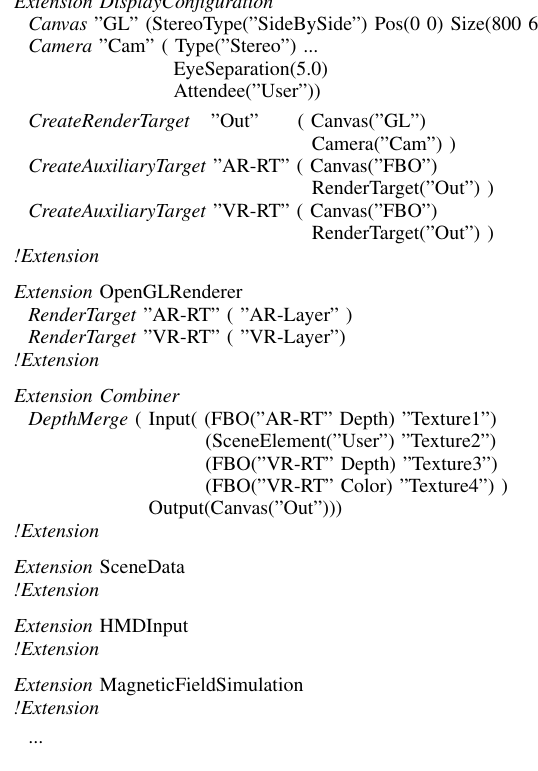
Fig. 8. A direct comparison of the RK4 method (top) and the Dopr853 method (bottom). Especially the field lines inside the magnets are more accurate for RK4, where Dopr853 should be much better.